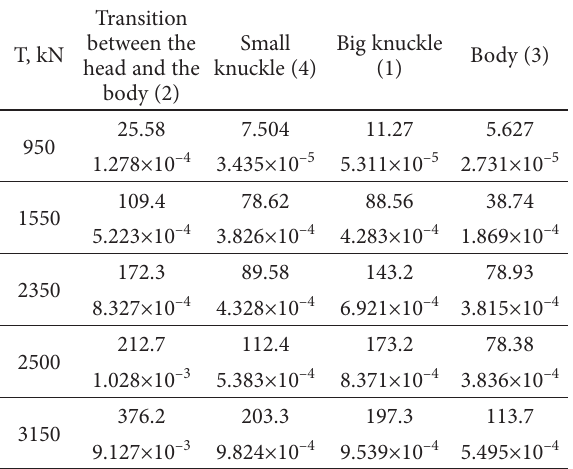
Table 2. Strains and stresses (MPa) in the body of the automatic coupler at the transition between the head and the body (2) for diff erent radii r 1 T, kN